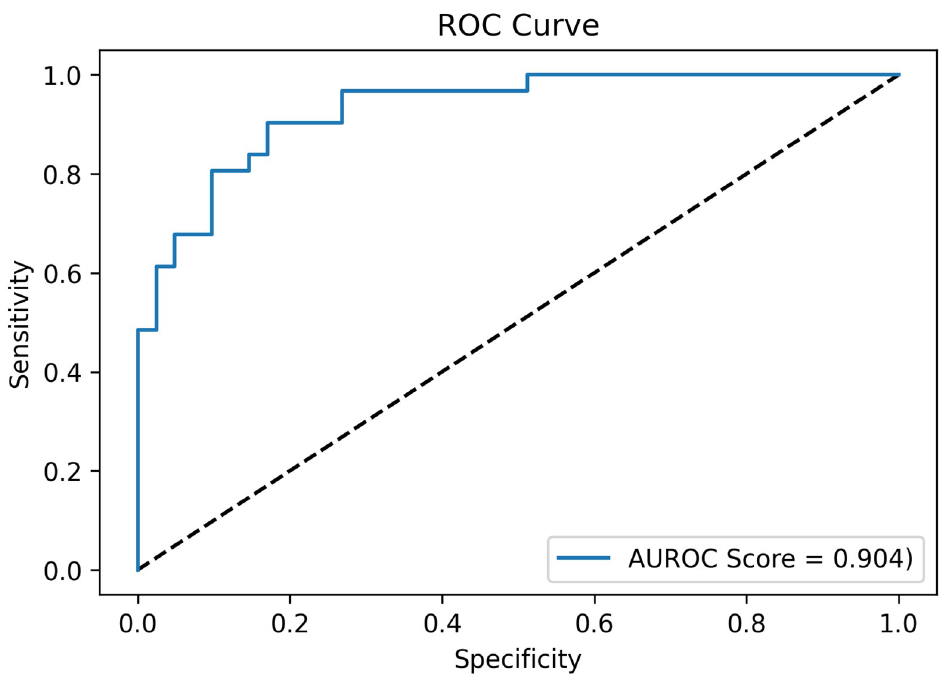
Fig 5. ROC curve of classification